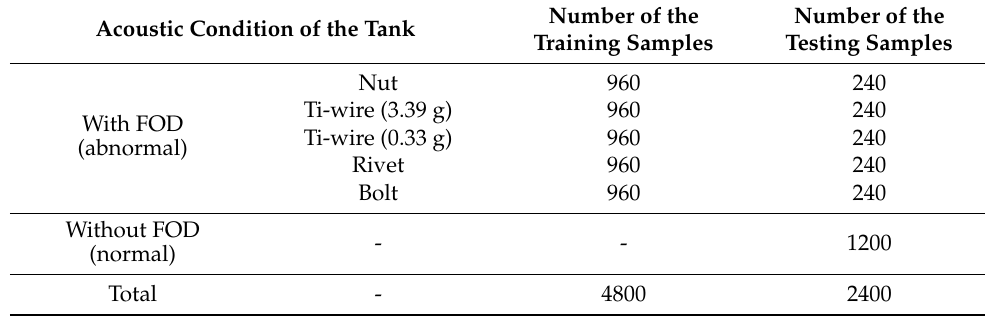
Table 1. Data set